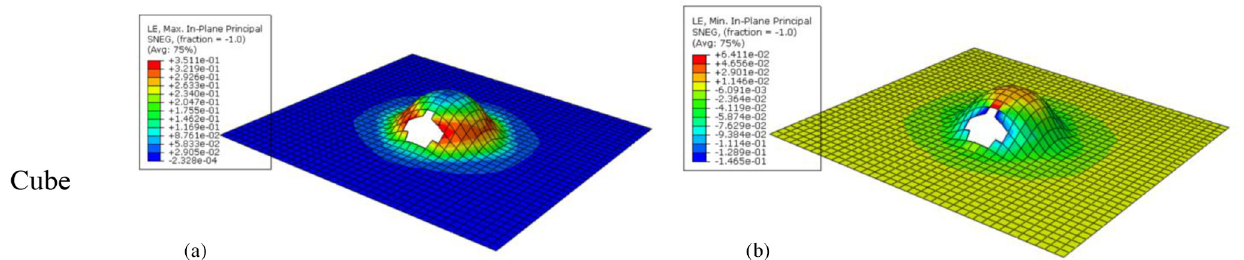
Fig. 9. (a) Maximum in-plane principle strain under biaxial stretching. (b) Minimum in-plane principle strain under biaxial stretching.